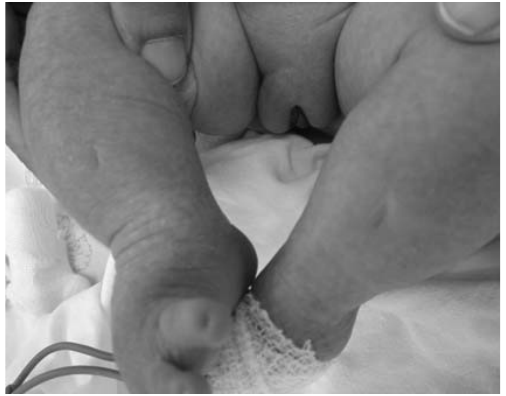
Figure 2 - X-rays showing (A) small thoracic cage, small scapulae, 11 pairs of ribs, (B) small iliac wings and mild bowing of femora and tibiae bilaterally.